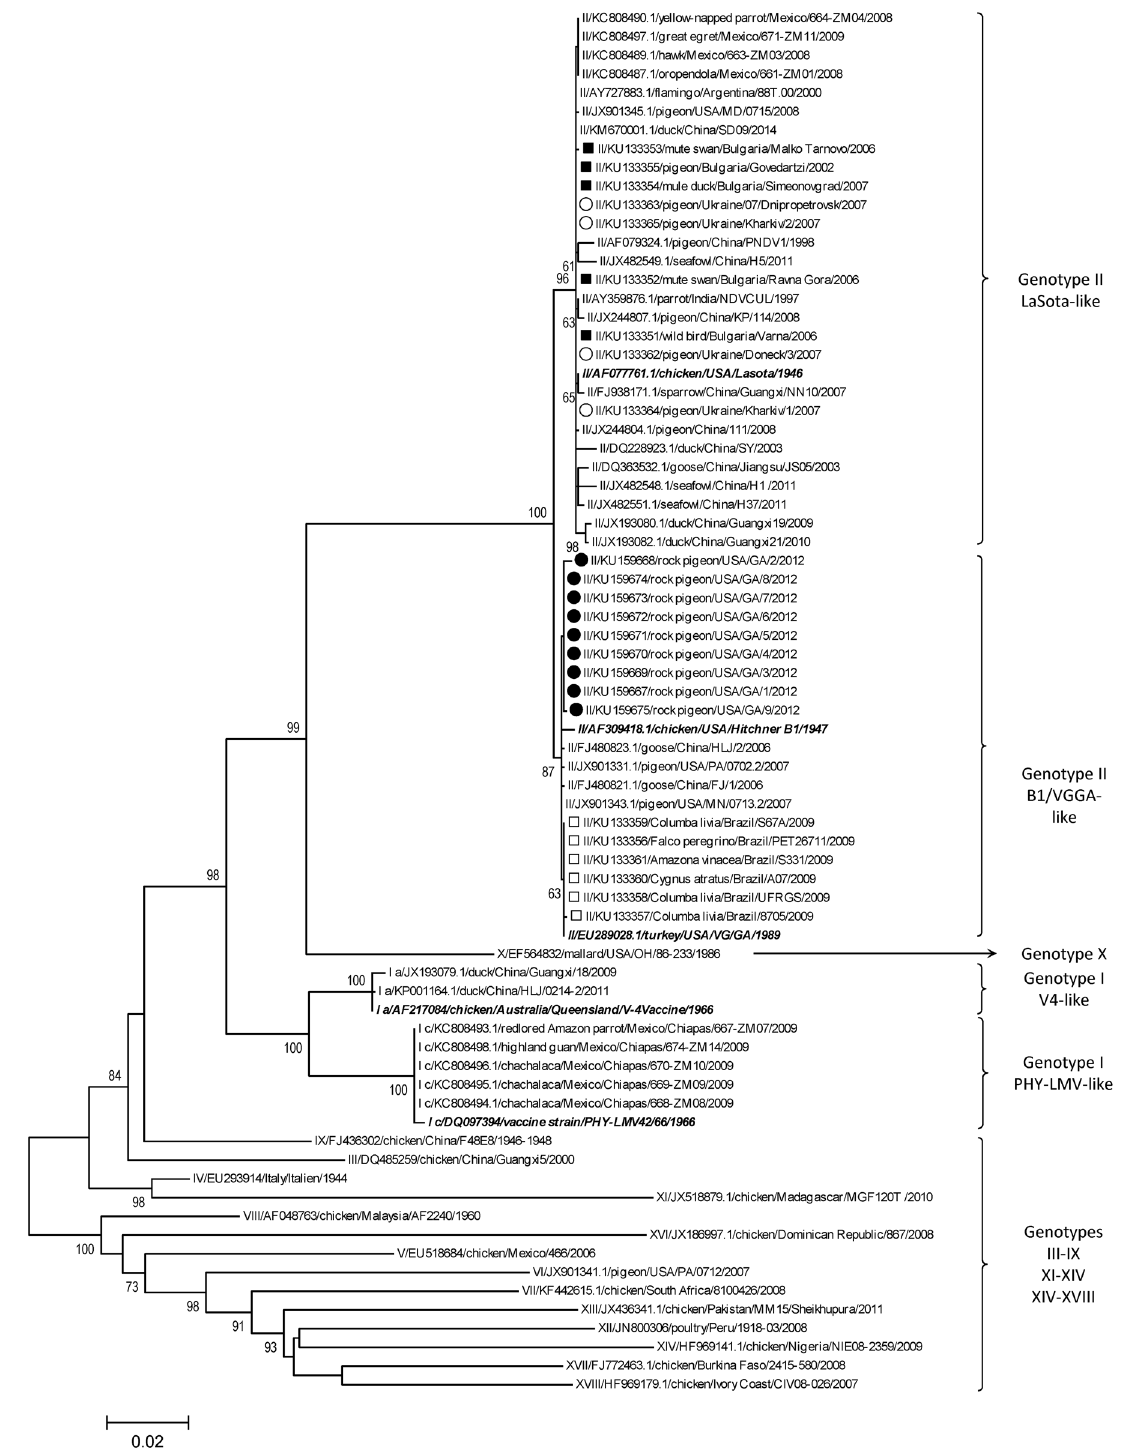
Fig 1. Phylogenetic tree of isolates and their relationship to class II NDV viruses. Phylogenetic analysis based on the complete nucleotide sequence of the fusion gene of isolates representing NDV class II. The evolutionary history was inferred by using the Maximum Likelihood method based on Tamura 3-parameter model with 500 bootstrap replicates [70]. The tree with the highest log likelihood (-108983.3717) is shown. A discrete Gamma distribution was used to model evolutionary rate differences among sites (4 categories (+G, parameter = 0.0936). The rate variation model allowed for some sites to be